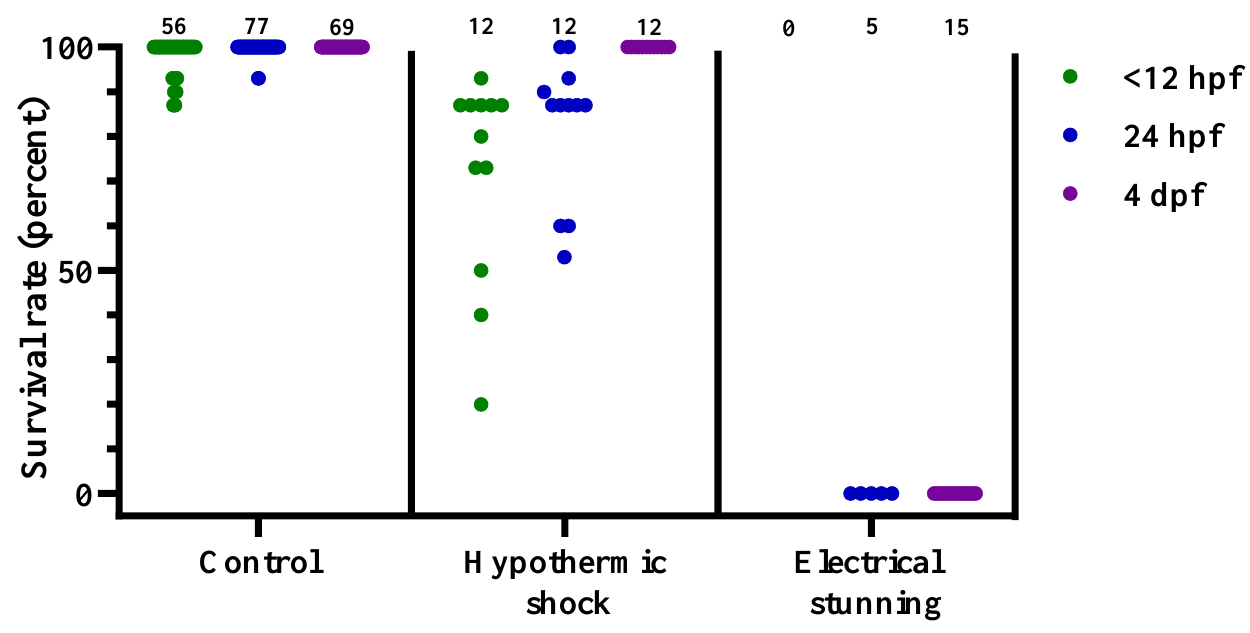
Figure 3. Survival rates for zebrafish following the control treatment, hypothermic shock, or electrical stunning, at 3 different developmental stages (<12 hpf, 24 hpf, and 4 dpf), presented as result per dish. Each dot represents one dish, with the total number of dishes per group indicated at the top of each column ( n = 0 – 77). hpf; hours post fertilization. dpf; days post fertilization.